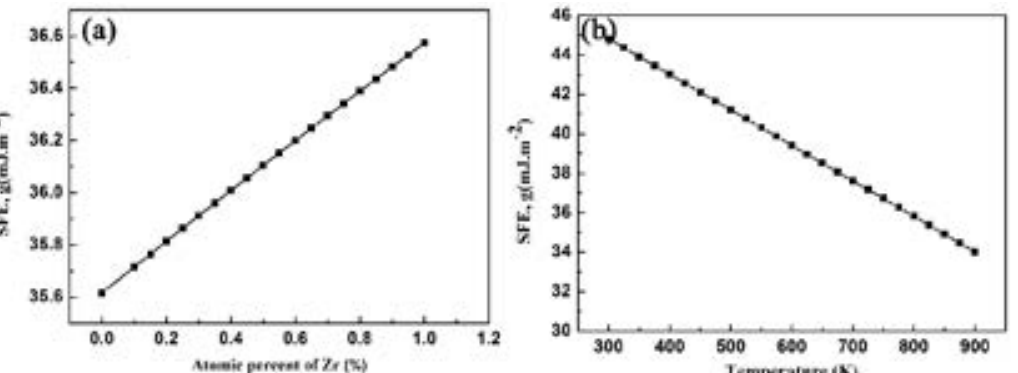
Figure 7. (a) Stacking fault energy (SFE) of Mg matrix with different content of Zr; (b) SFE of Mg-0.2Zr (at. %) at different temperature.